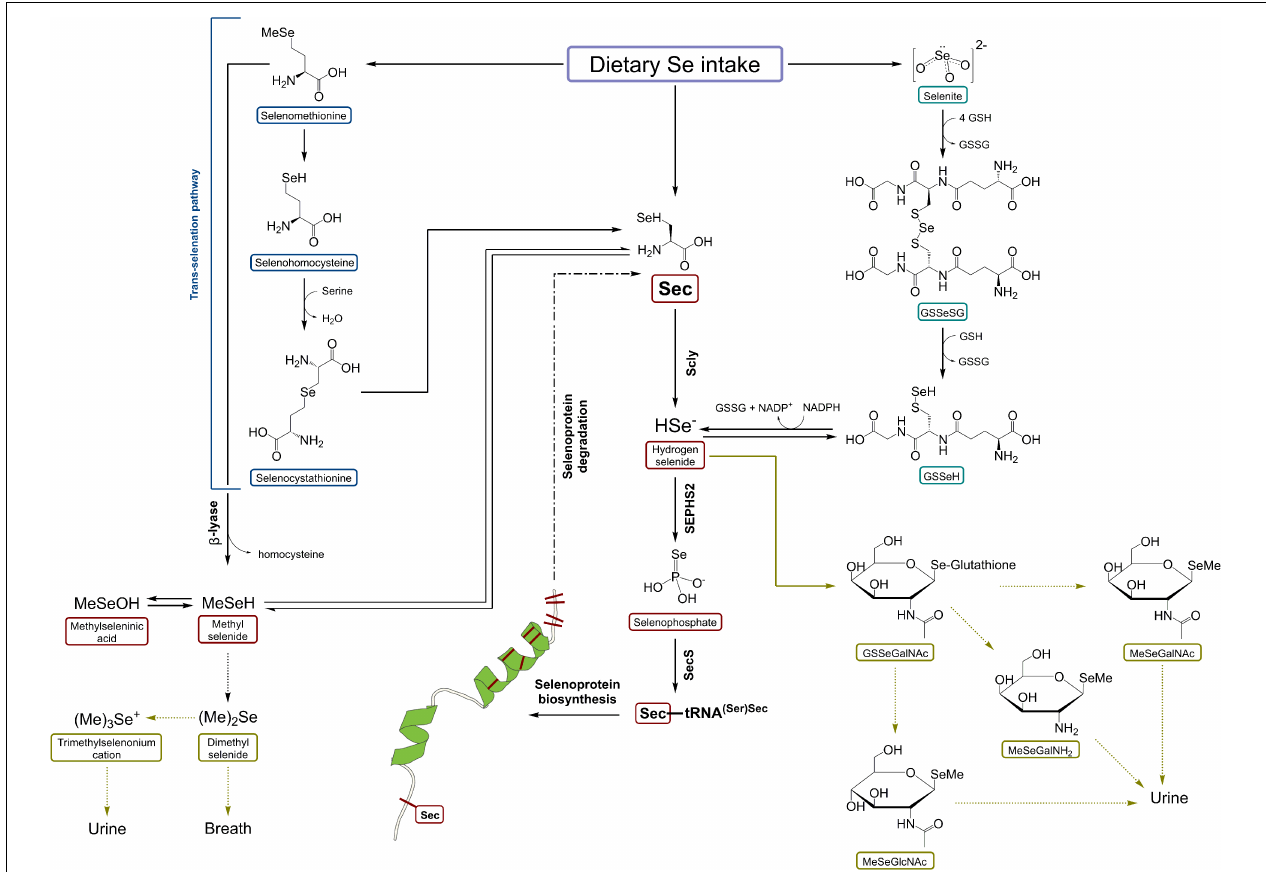
FIGURE 3 | A schematic representation of selenocysteine β -lyase role in Se metabolism. Scly – selenocysteine β -lyase; Sec – selenocysteine; SeMet – selenomethionine; HSe - – hydrogen selenide; GSSeSG – selenodiglutathione; GSSeH – selenoglutathione; SEPHS2 – selenophosphate synthetase 2. Based on Seale (2019) with